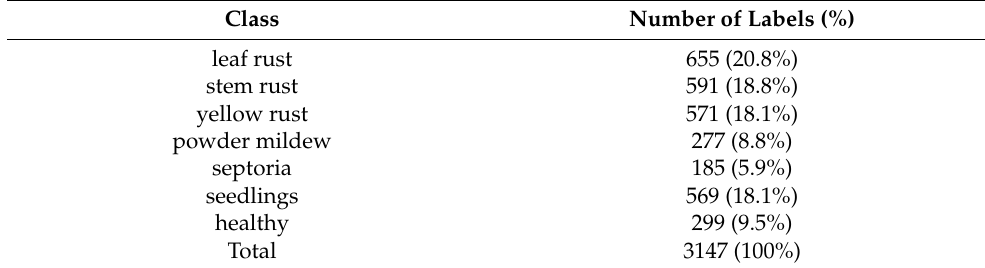
Table 3. The number of labels of each class in the WFD2020